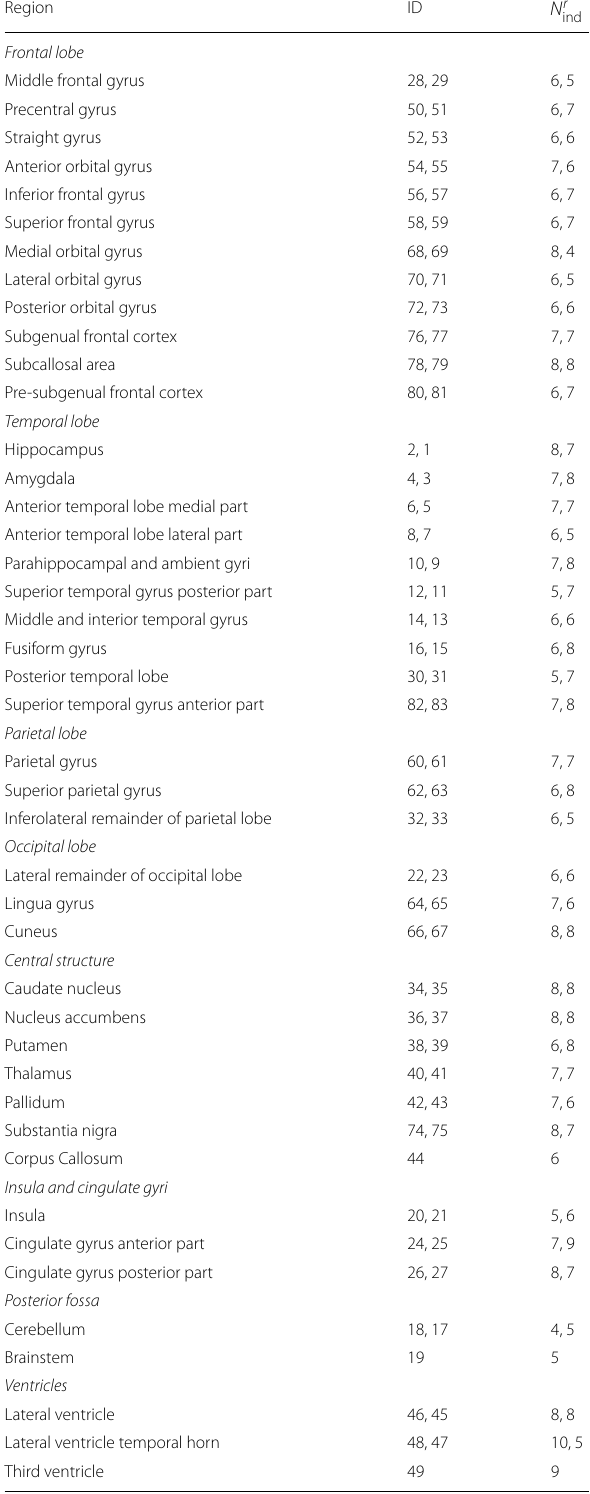
Table 3 Brain regions and number of principal